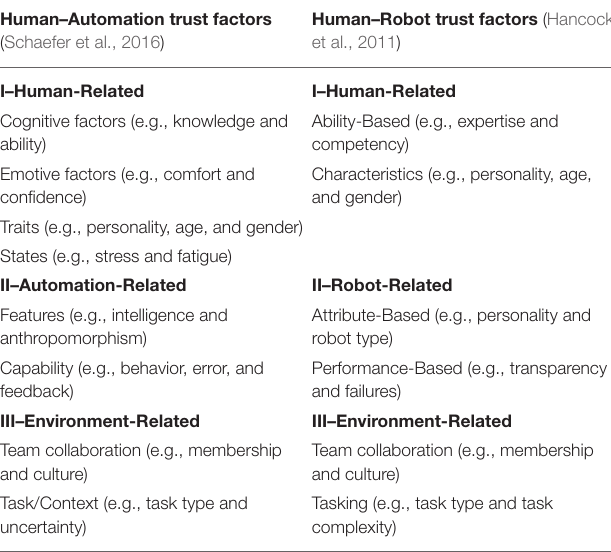
TABLE 1 | Comparison of human–automation and human–robot trust